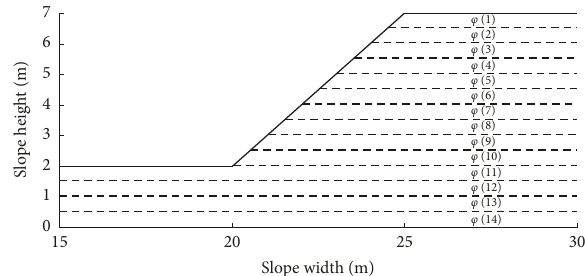
Figure 5: Illustration of vertical spatial variability of friction angle for homogeneous